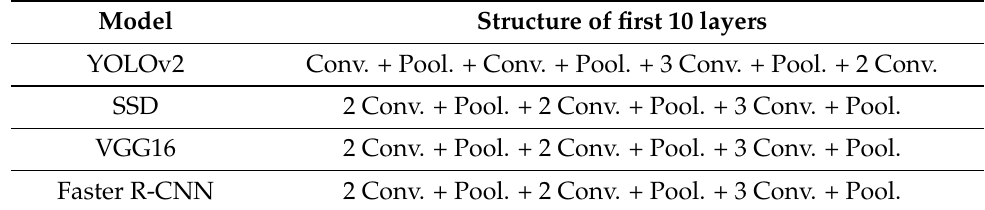
Table 1. Initial 10-layer designs for example object detection models.